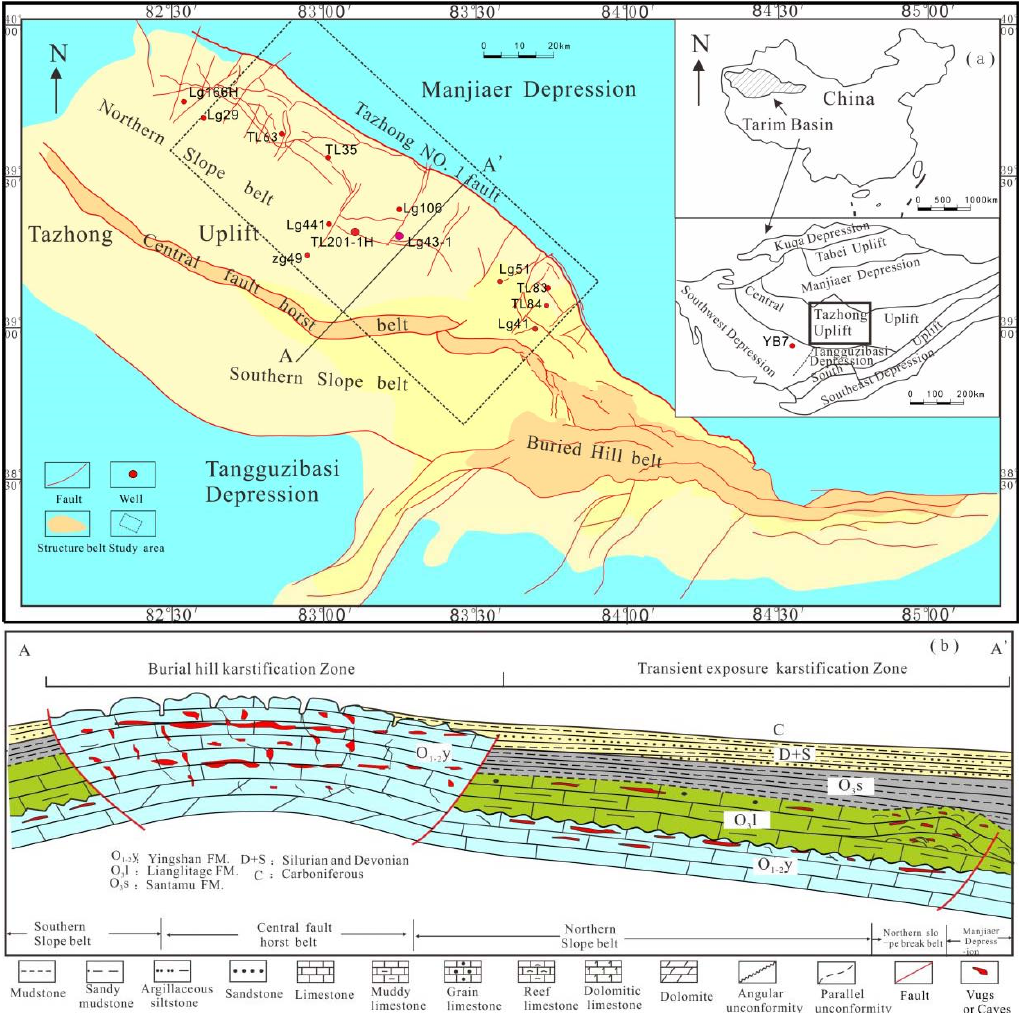
Figure 1. Location and geology of study area. ( a ) Tectonic division of Tazhong Uplift and location of study area [19]; ( b ) karstification division of Tazhong Uplift and location of northern slope belt.